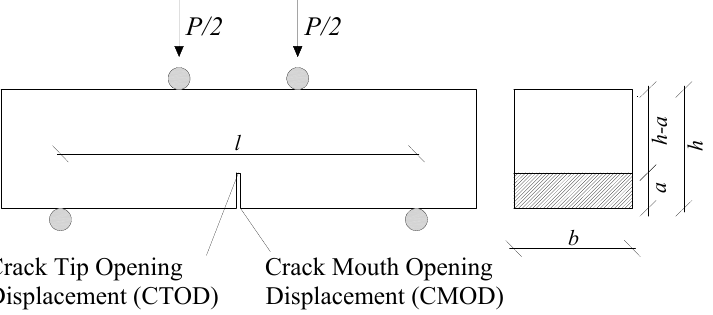
Figure 1. Four-point bending (4PB) test set-up.